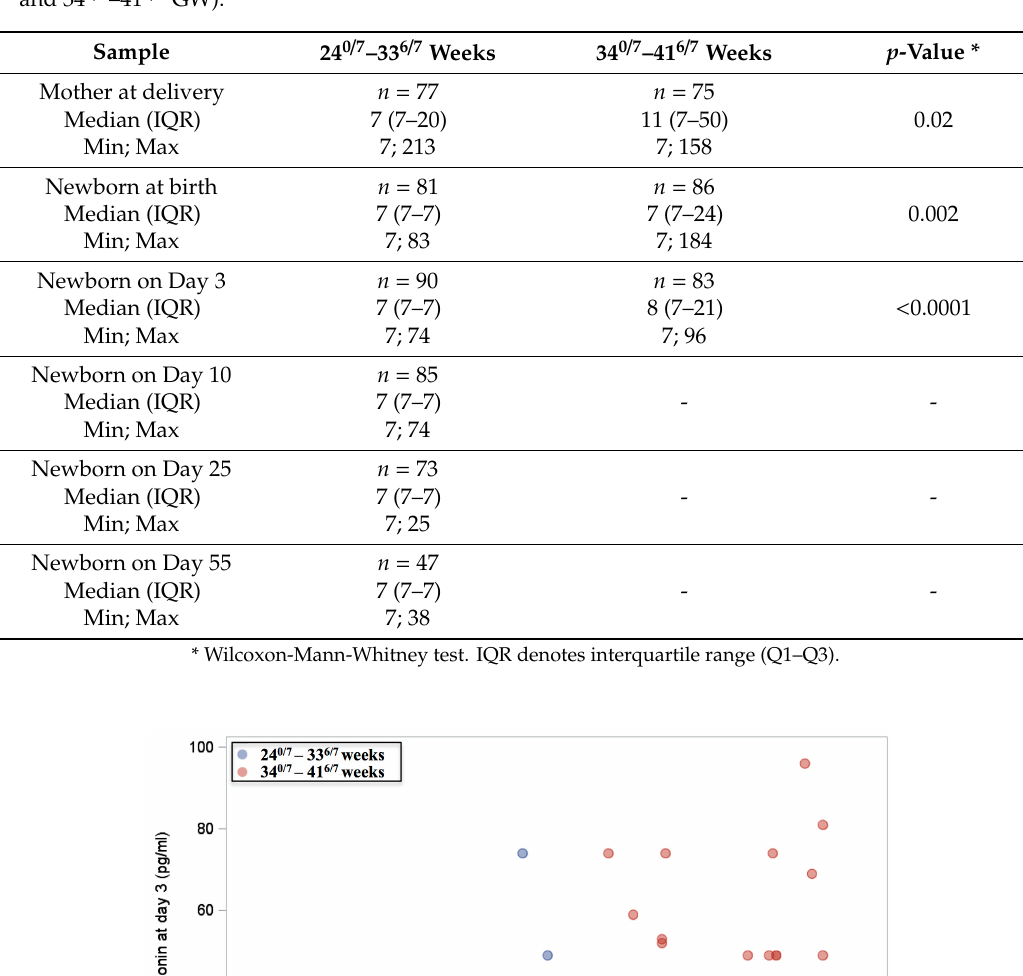
Table 1. Plasma melatonin concentrations (in pg / mL) in the mother at delivery and in newborns at birth and on Days 3, 10, 25 and 55, compared between the two gestational age groups (24 0 / 7 –33 6 / 7 GW and 34 0 / 7 –41 6 / 7 GW).